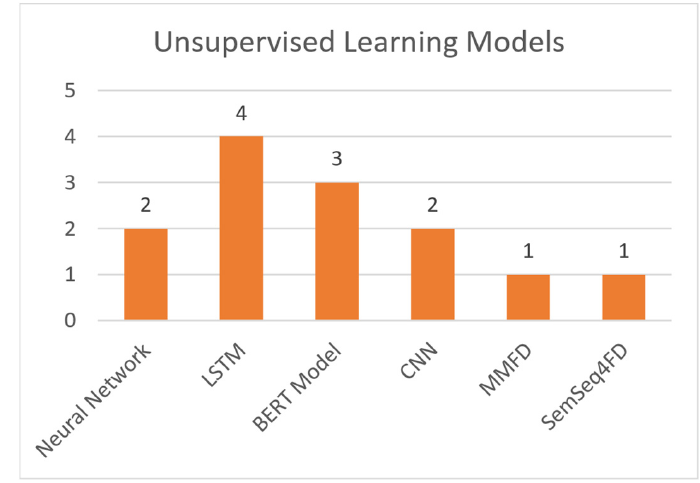
Figure 6. Unsupervised learning techniques used in misinformation.